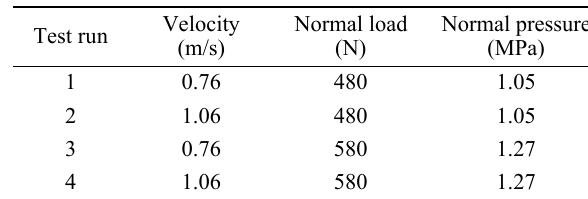
Table 1 Experimental conditions parameters in rotating friction